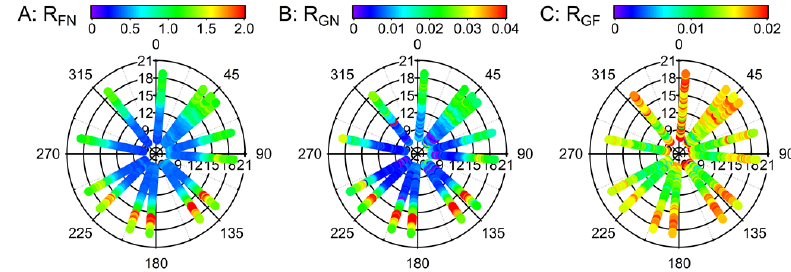
Figure 10. Azimuth dependence of the time series of the trace gas ratios R FN , R GN , and R GF on 17 June 2013. See text for